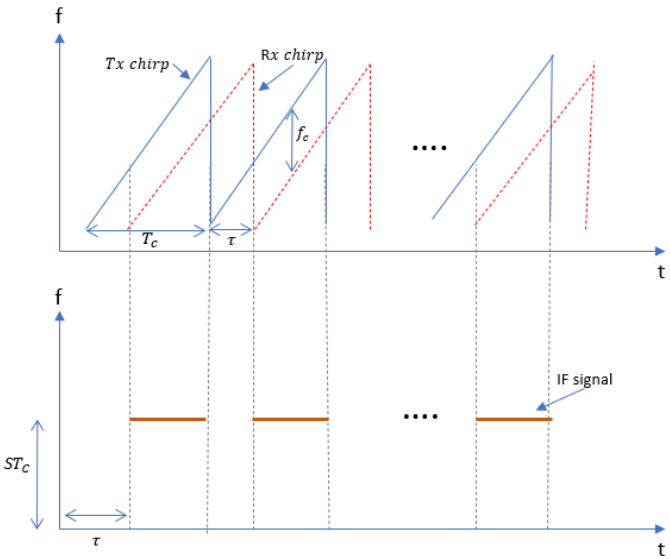
Figure 2. Transmitted and received chirp signals where each chirp is a sinusoidal signal with a slope S and time delay between transmitted and received chirp 𝜏 when the sweeping bandwidth is S 𝜏.